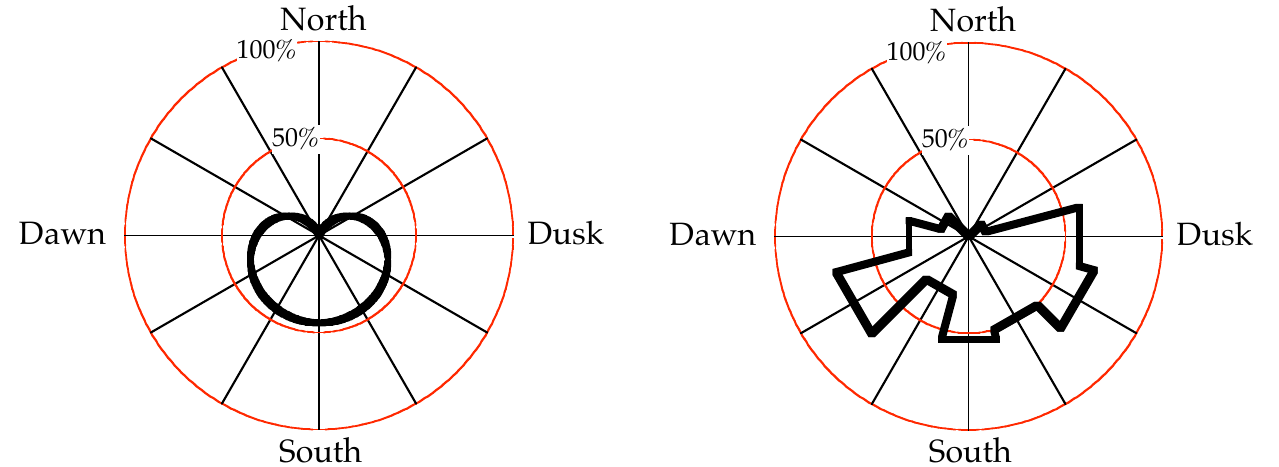
Fig. 5. The percentage of FTEs with perturbation amplitudes pre- Figure 5 dicted to exceed 10nT as a function of the direction of the magne- tosheath magnetic field orientation.